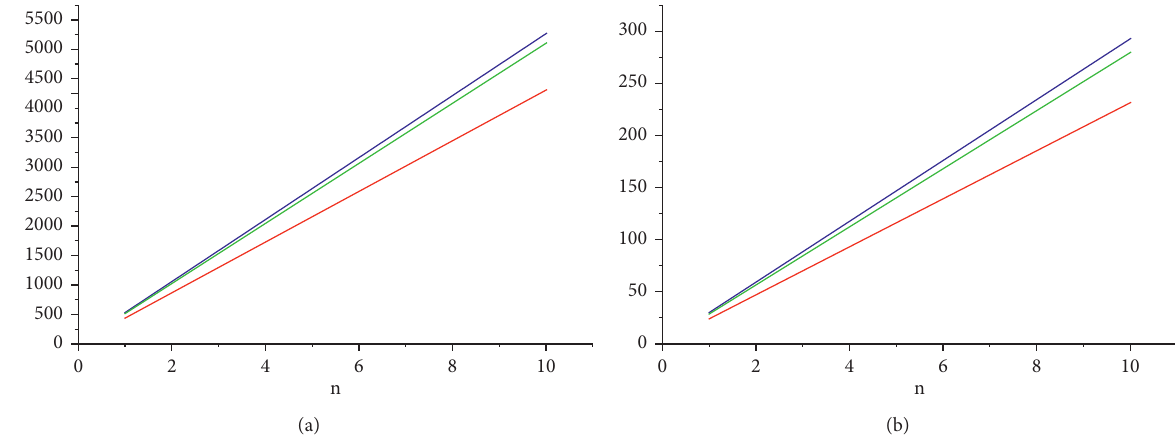
Figure 9: Comparison of F and ABC indices of guar gum, HPG and CMG, and CMHPG. (a) F (guar gum) in red, F (HPG and CMG) in green, and F (CMHPG) in blue; (b) ABC (guar gum) in red, ABC (HPG and CMG) in green, and ABC (CMHPG) in blue.